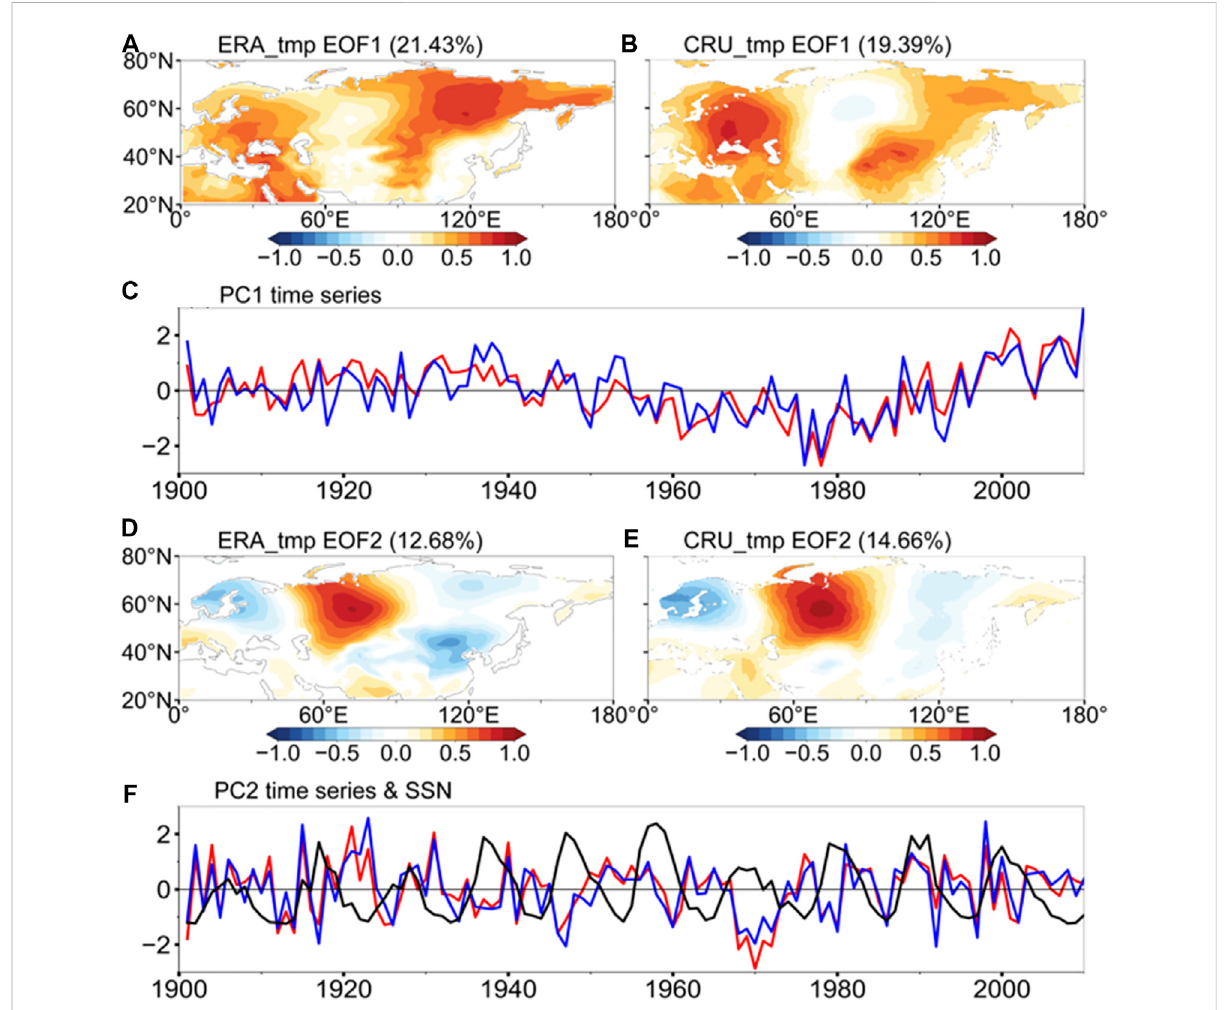
FIGURE 2 Spatialpatternsandthecorrespondingnormalizedtimeseriesfortheleading fi rst (A – C) andsecond (D – F)